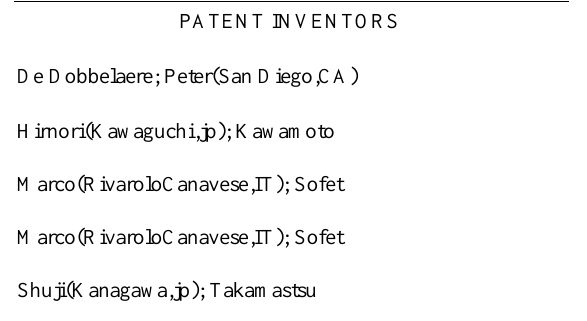
Table 3. Database after applying database sorting